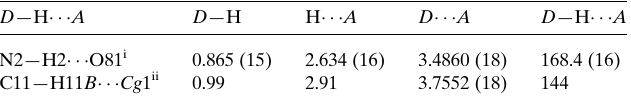
Table 1 Hydrogen-bond geometry (A˚ , (cid:2) ).